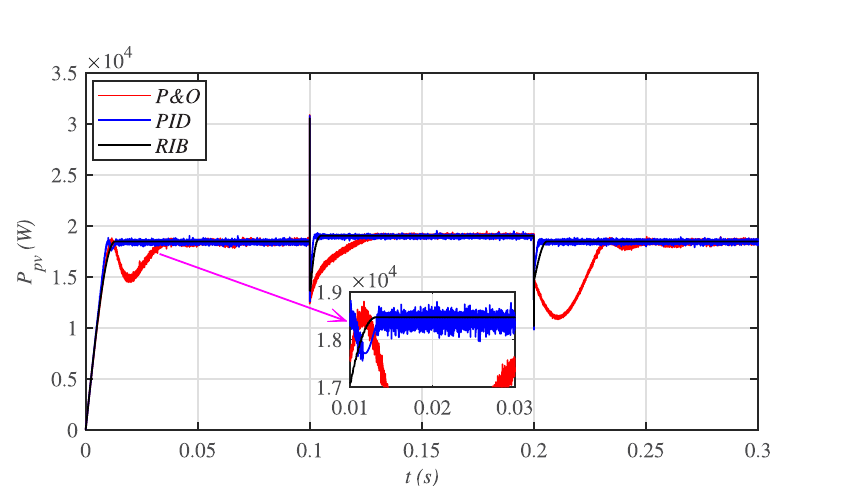
Fig 28. PV array comparative powers under varying meteorological conditions.